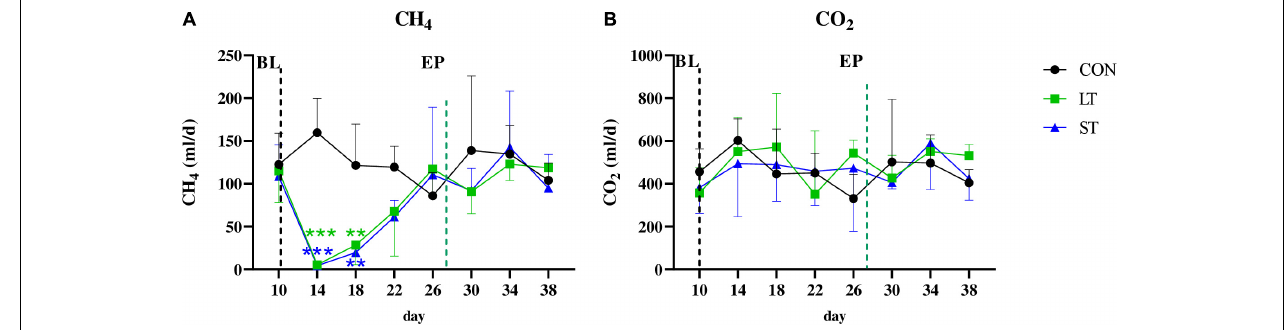
FIGURE 1 | Daily production rates of methane (A) and carbon dioxide (B) during baseline period (BL, day 10) and experimental period (EP). The black line indicates the beginning of the EP. The green line indicates termination of Mootral supplementation in the short-term (ST) group. CON, control group; LT, long-term group. Significant differences between treatments and the control group in the Tukey post hoc test are indicated by *** P < 0.001, ** P < 0.01. Data are presented as means ±